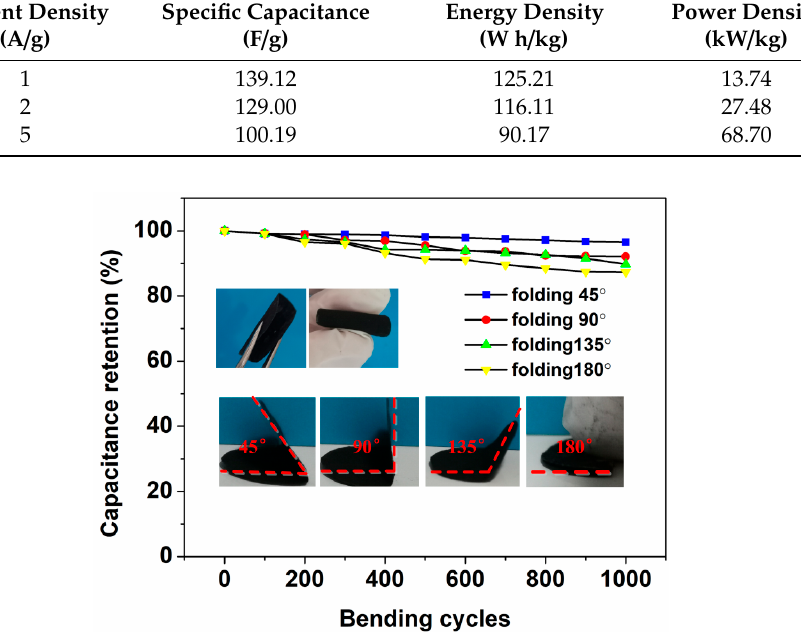
Figure 6. Capacitance retention of the AS at different folding degrees.